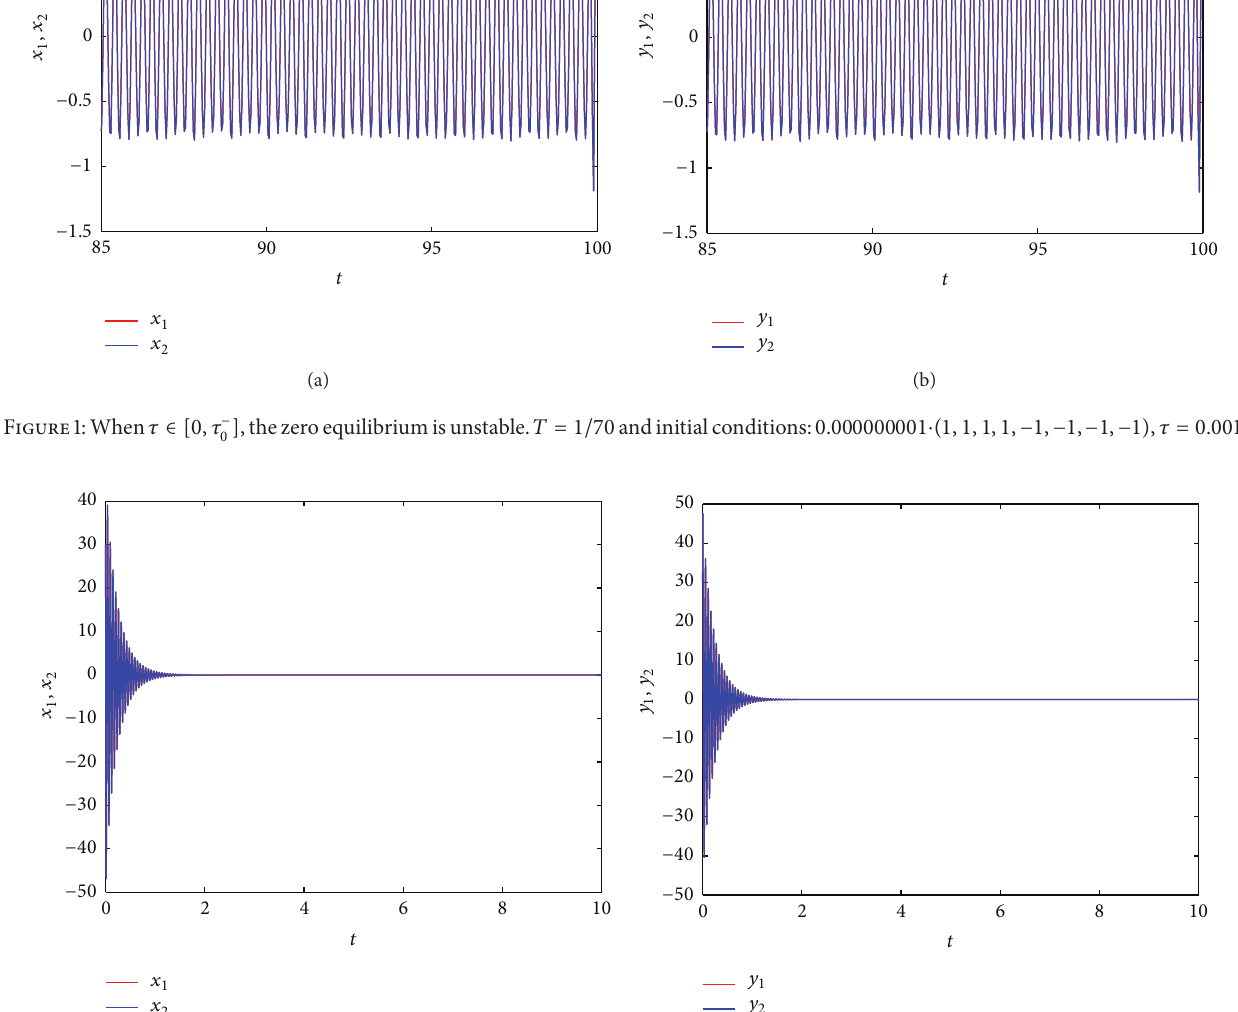
Theorem 7. Assume that 𝛽 defined by (32) - (33) ,